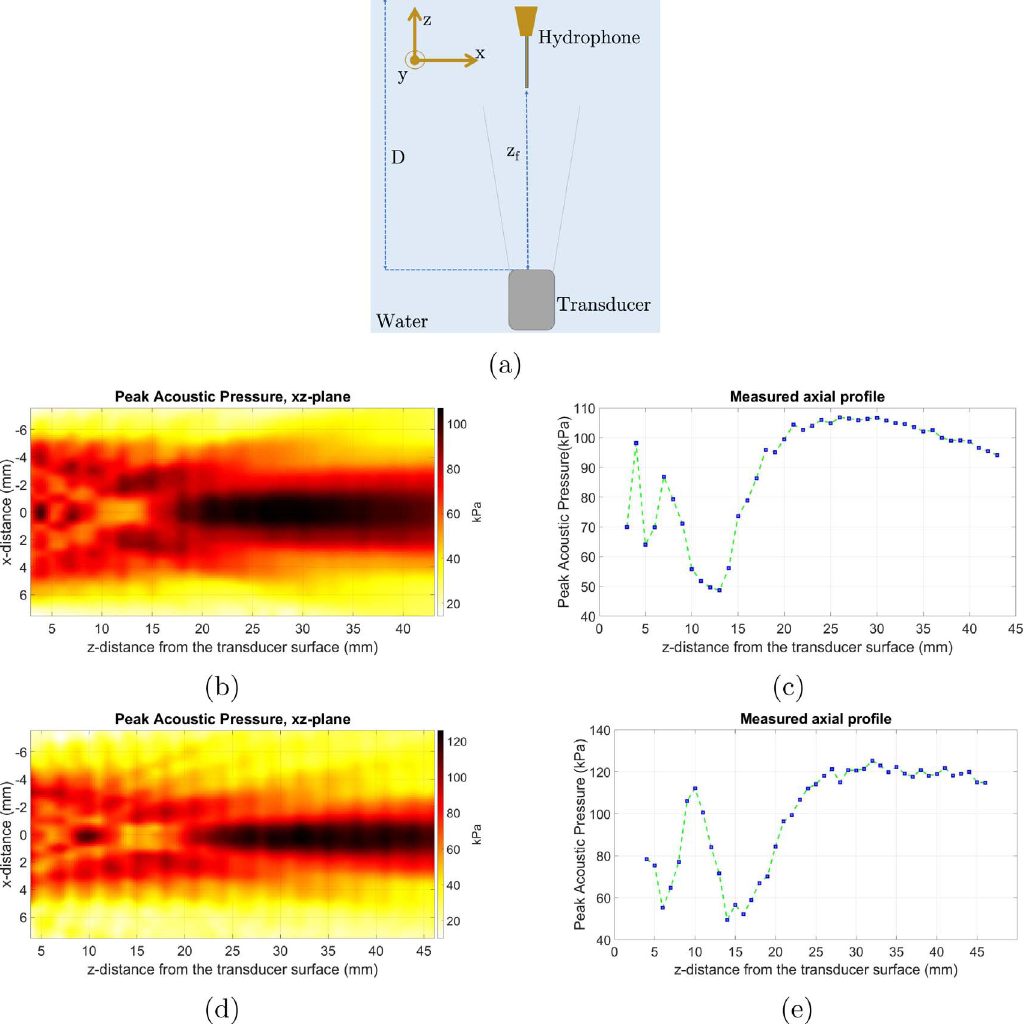
Figure 4. Calibration con fi guration (a). Pressure distribution in xz -plane for the 1 MHz-transducer for free fi eld (b) and along the beam axis (c). Pressure distribution in xz -plane for the 2.25 MHz-transducer for free fi eld (d) and along the beam axis